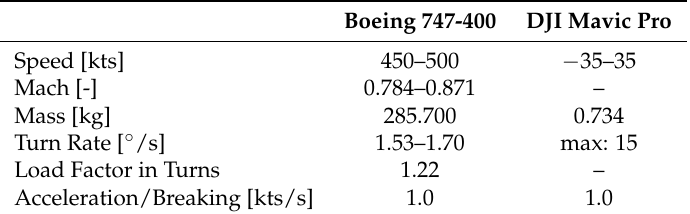
Table 6. Performance data for Boeing 747-400 and DJI Mavic Pro used with BlueSky